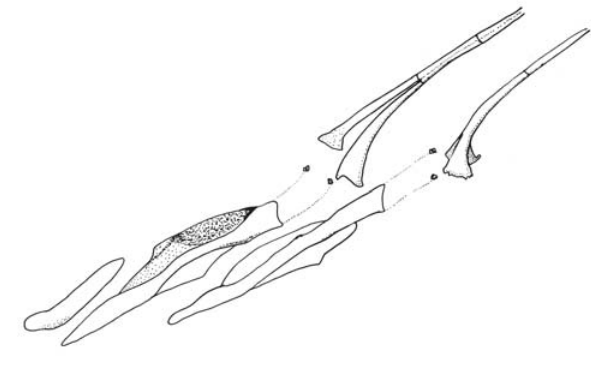
Fig. 4. Gladioglanis anacanthus , paratype, INPA 28447, 21.5 mm SL. First three dorsal-fin pterygiophores and the first and second dorsal-fin rays. Lateral view, anterior toward